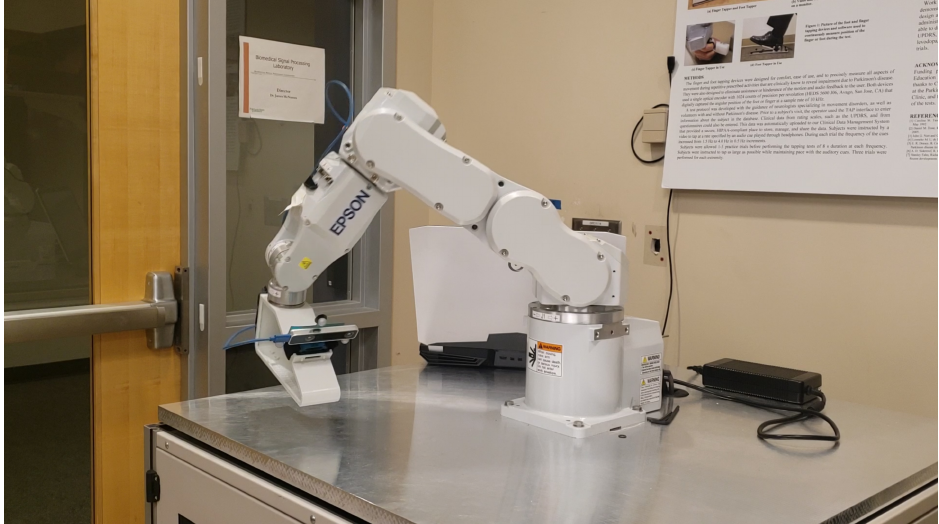
Figure 3. Intel T265 camera attached to Epson C3 robotic arm with custom foot jig.